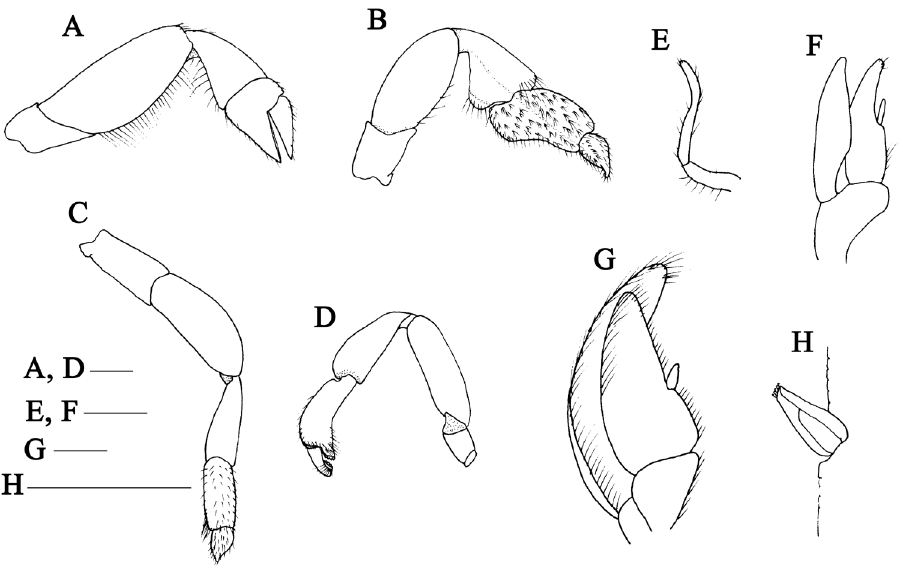
Figure 2. Calliaxina xishaensis sp. n. A–H Holotype female, MBM136806/58C-639 A–D pereopods 2-5, lateral views E pleopod 1, posterior view F pleopod 2, posterior view G pleopod 3, posterior view H appendix interna of pleopod 3, posterior view. Scale bars: 1